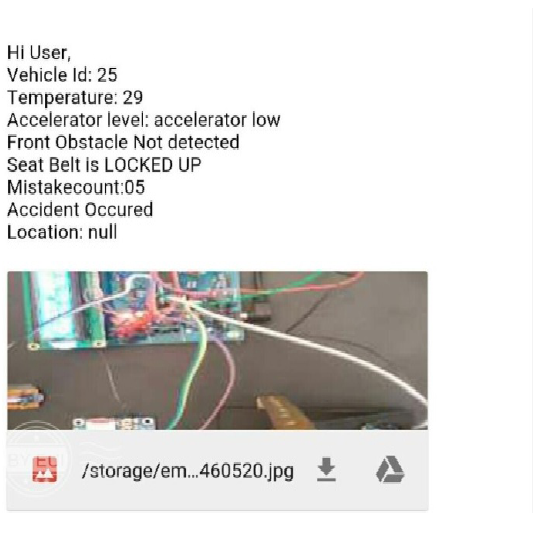
Figure 12. Result of the proposed system